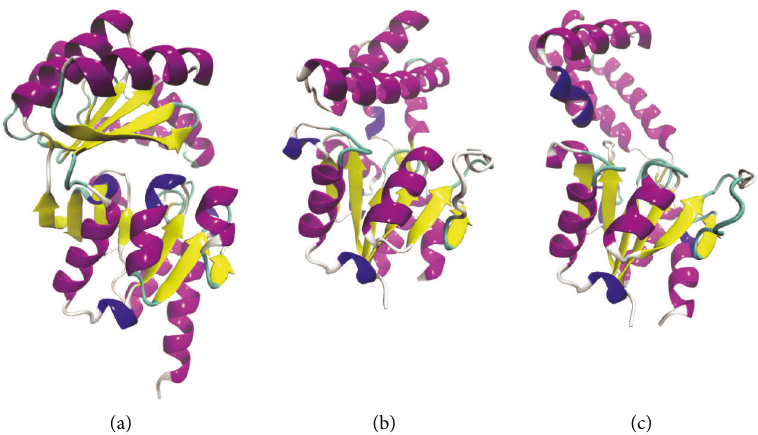
Figure 2: The tertiary structure comparison of (a) Bcfd1 with (b) L-DEX YL from Pseudomonas sp. YL and (c) ps-2-HAD from P. syringae . Bcfd1 has a main domain similar to the main domain of ps-2-HAD and L-DEX YL but the cap domain is significantly different.